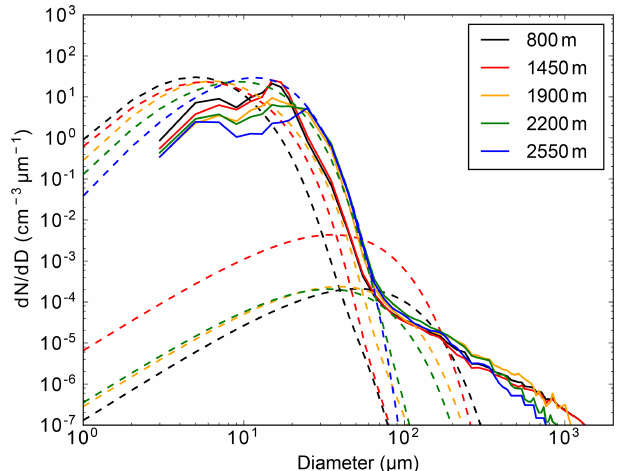
Figure 9. Evaluation of cloud and rain droplet size distributions (in micrometres) at the altitudes sampled by the aircraft. The sim- ulations are from the 500m resolution model. The observed size distributions are shown by solid lines and the simulated distribu- tions by dotted lines. The observation data are combined from the cloud droplet probe (CDP), two-dimensional stereo probe (2DS) and cloud imaging probe (CIP). The CDP data and simulated cloud droplet concentrations are filtered to be in cloud, i.e. to include only samples with LWC > 0 . 01gkg − 1 , while the CIP data and simulated rain are